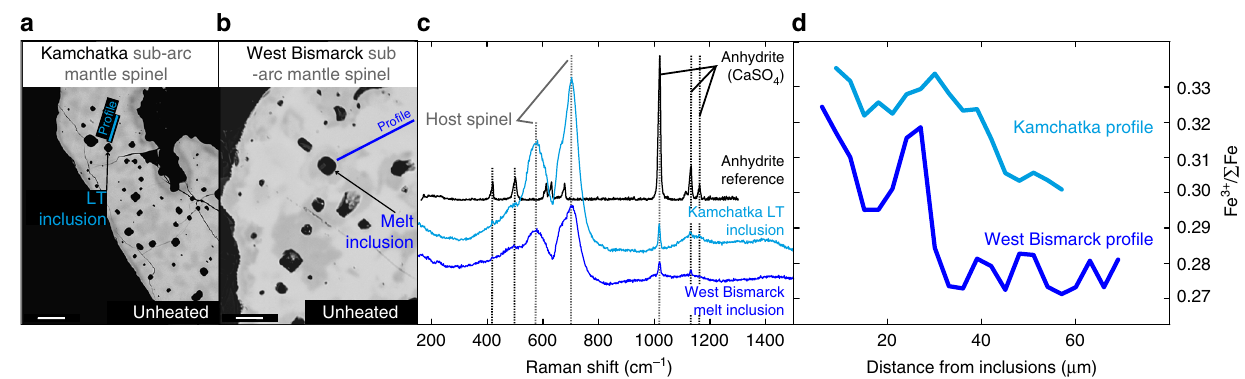
Fig. 3 Coexisting anhydrite in glass (formerly melt) inclusions (MI) and increased ferric iron abundances in their host spinel from the mantle lithosphere beneath Kamchatka and West Bismarck arcs. Back-scattered electron (BSE) images of chemical zoning (halos) of a Kamchatka and b West Bismarck inclusion-bearing mantle spinel. Scale bar lengths are respectively ~50 µ m in a and ~20 µ m in b . c Raman spectra of the inclusions (LT inclusions and West Bismarck MI) in a , b plus an anhydrite (CaSO 4 ) reference (black spectrum). d Measured Fe 3 + / ∑ Fe pro fi les in spinel adjacent to the inclusions indicated with lines in a , b . The variable contrast of spinel visible in the BSE images in a , b is related to changes in the concentrations of Al, Cr, Fe and Mg in irregular halos surrounding anhydrite-bearing MI (Supplementary Tables 5 and 6). Note that all inclusions for which data are presented here